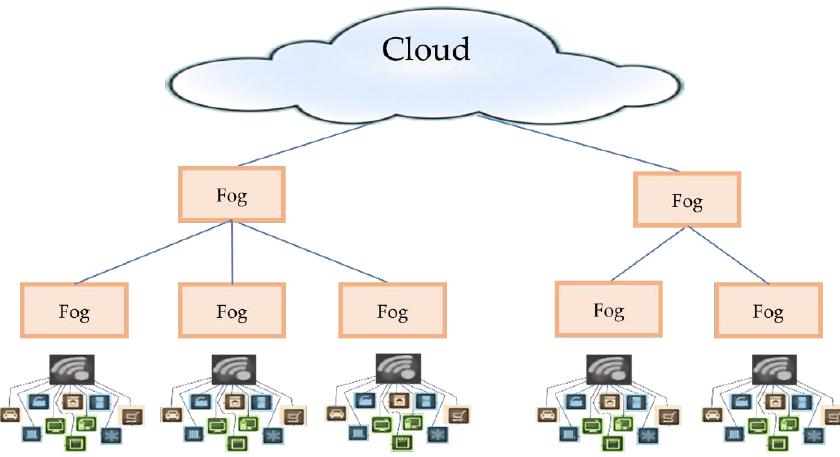
Figure 2. iIFCs architecture (two-level hierarchical fog architecture).